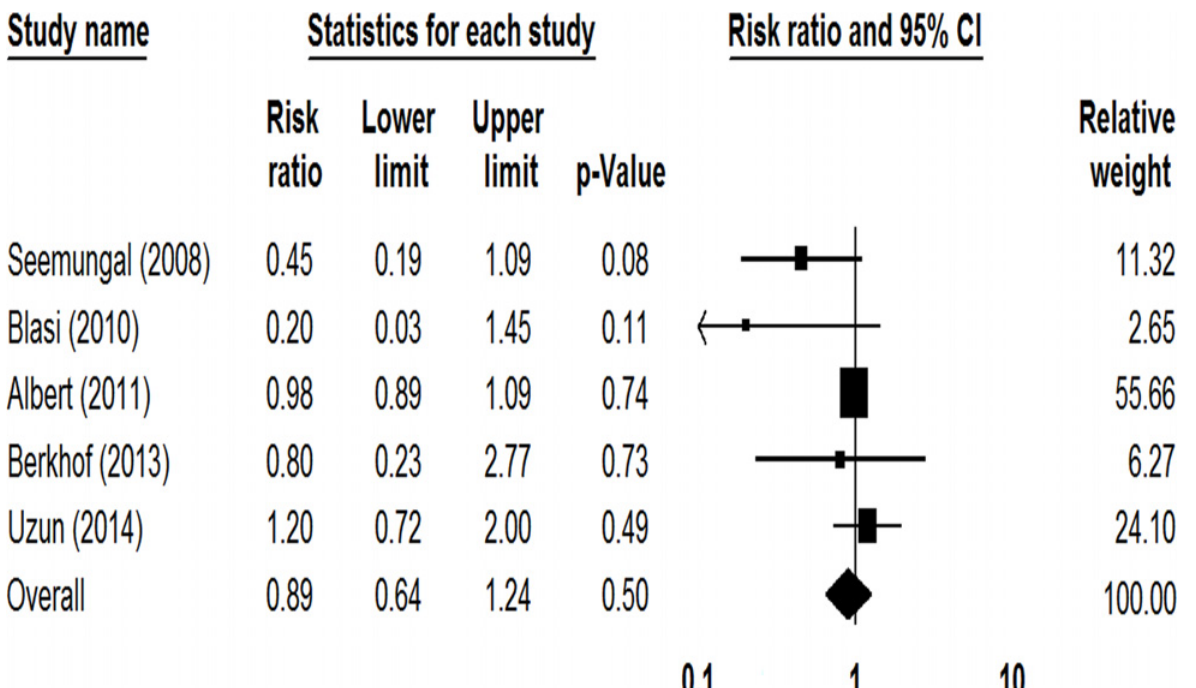
Fig 4. Forest plot assessing risk ratio of hospitalization among COPD patients treated with macrolides compared with the